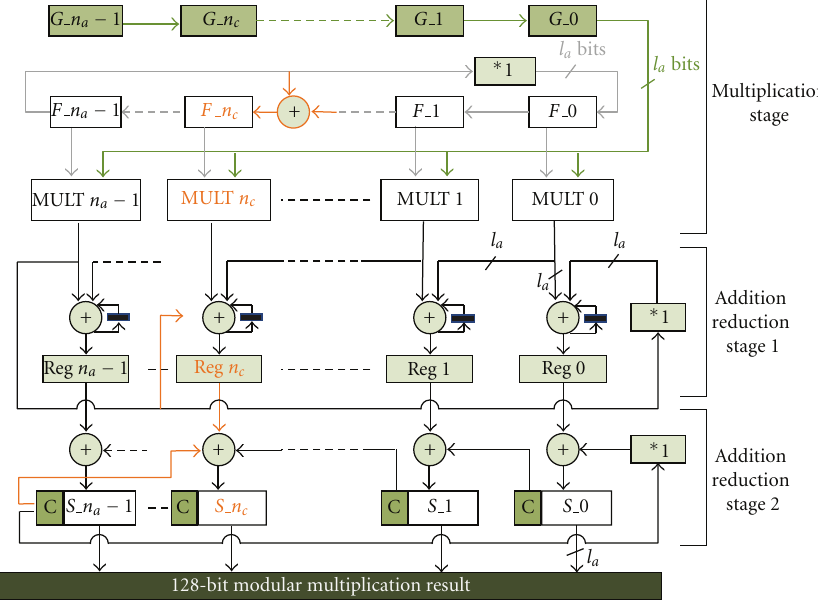
Figure 3: Modular multiplication architecture: extension to NIST P-192